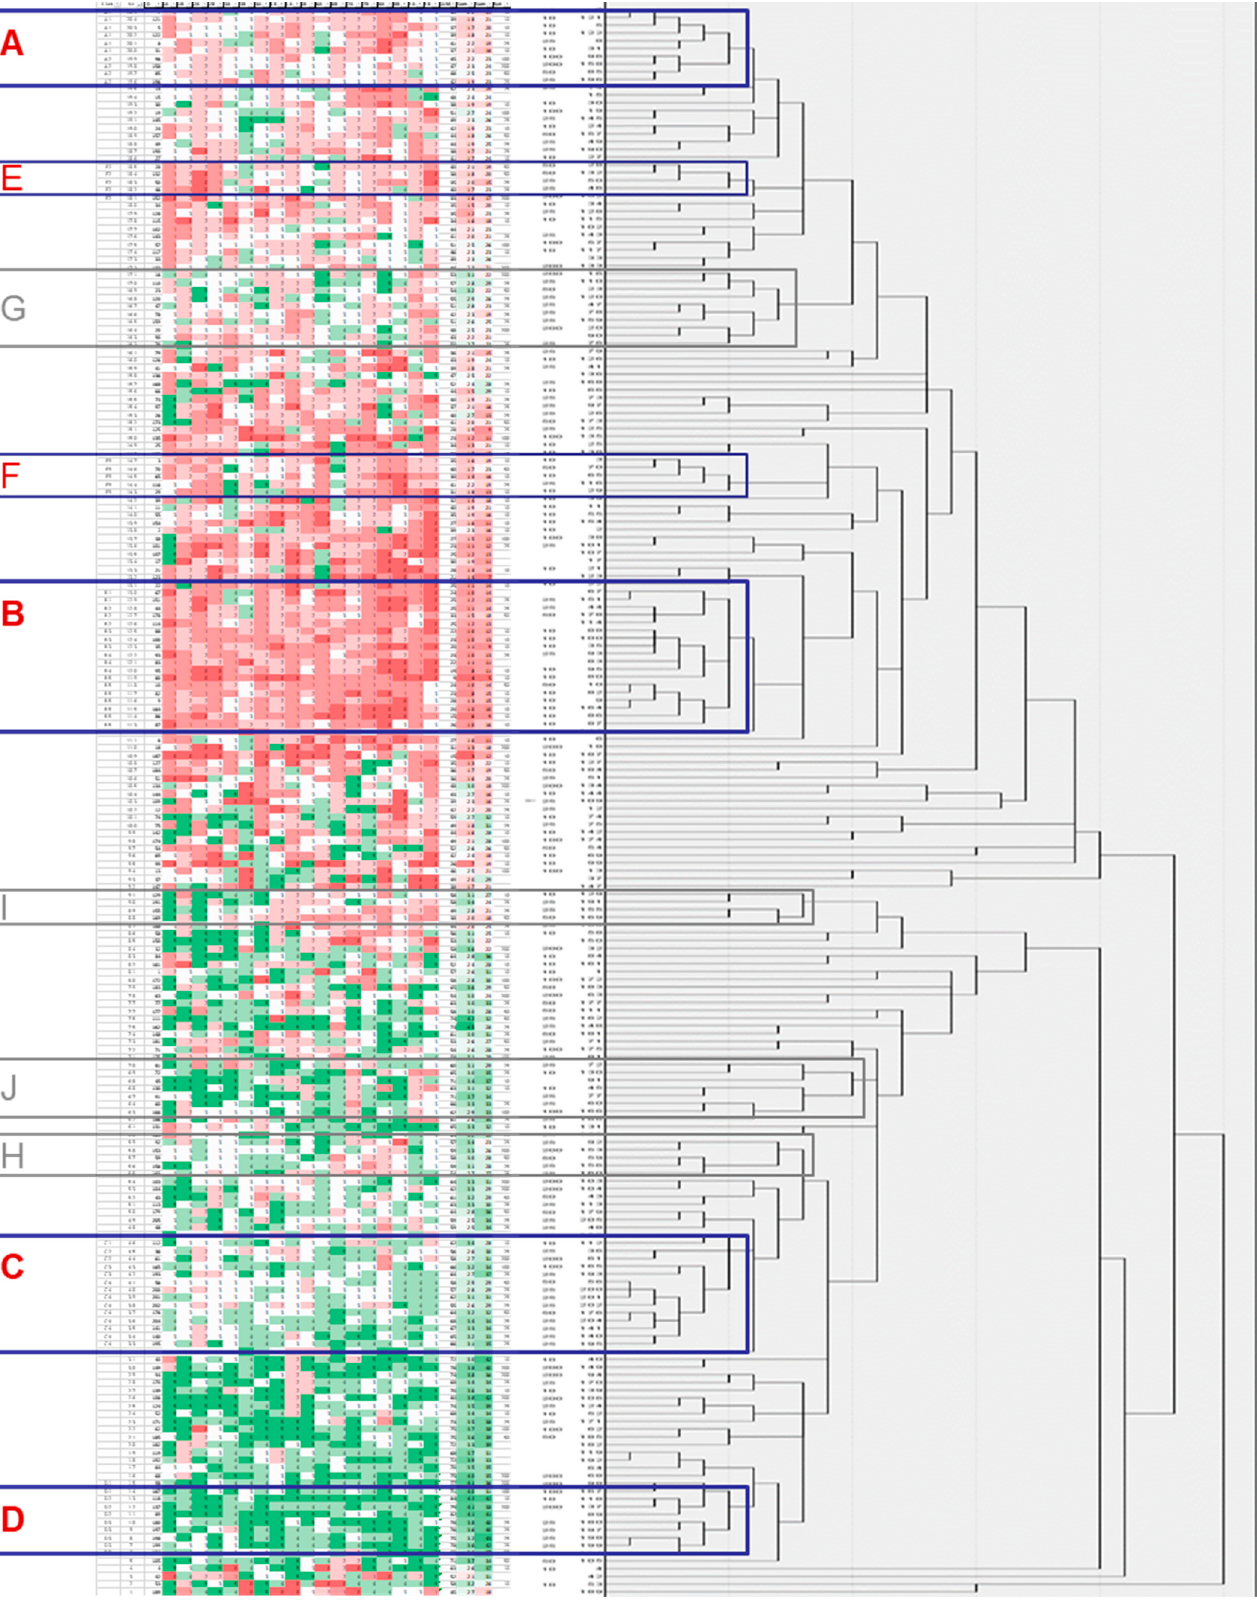
Figure 5. Clusters illustrated by individual responses (left) combined with a dendrogram (right)